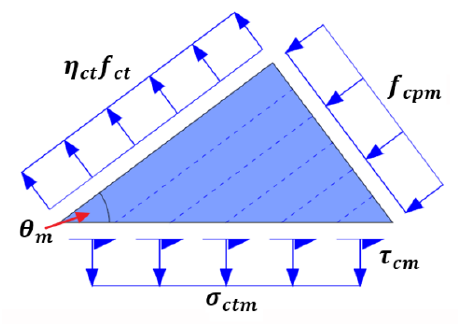
Figure 15. The average stress field for cracked concrete block.